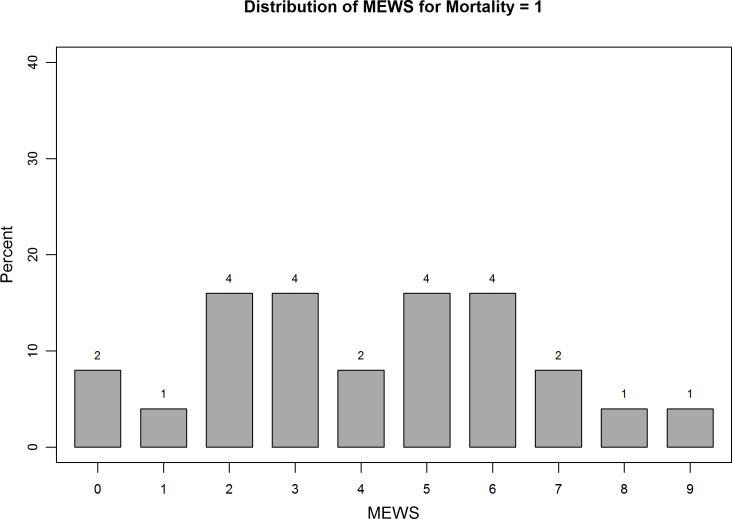
Distribution of MEWS across all patients who died.The distribution of MEWS across patients who did not survive illustrates that MEWS ≥4 was documented in 21.5% of patients; 11.7% of patients had a MEWS ≥5.